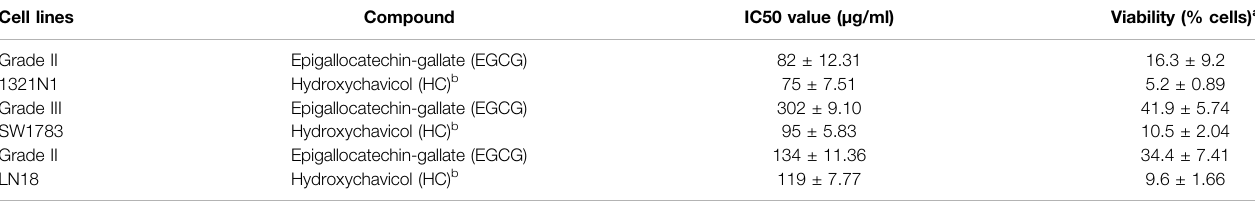
TABLE 1 | 50% Inhibitory concentration (IC50) of EGCG and HC on 1321N1, SW1783 and LN18 cells. Viable cells (%) were expressed as the mean ± SD of three independent experiments. Cell lines